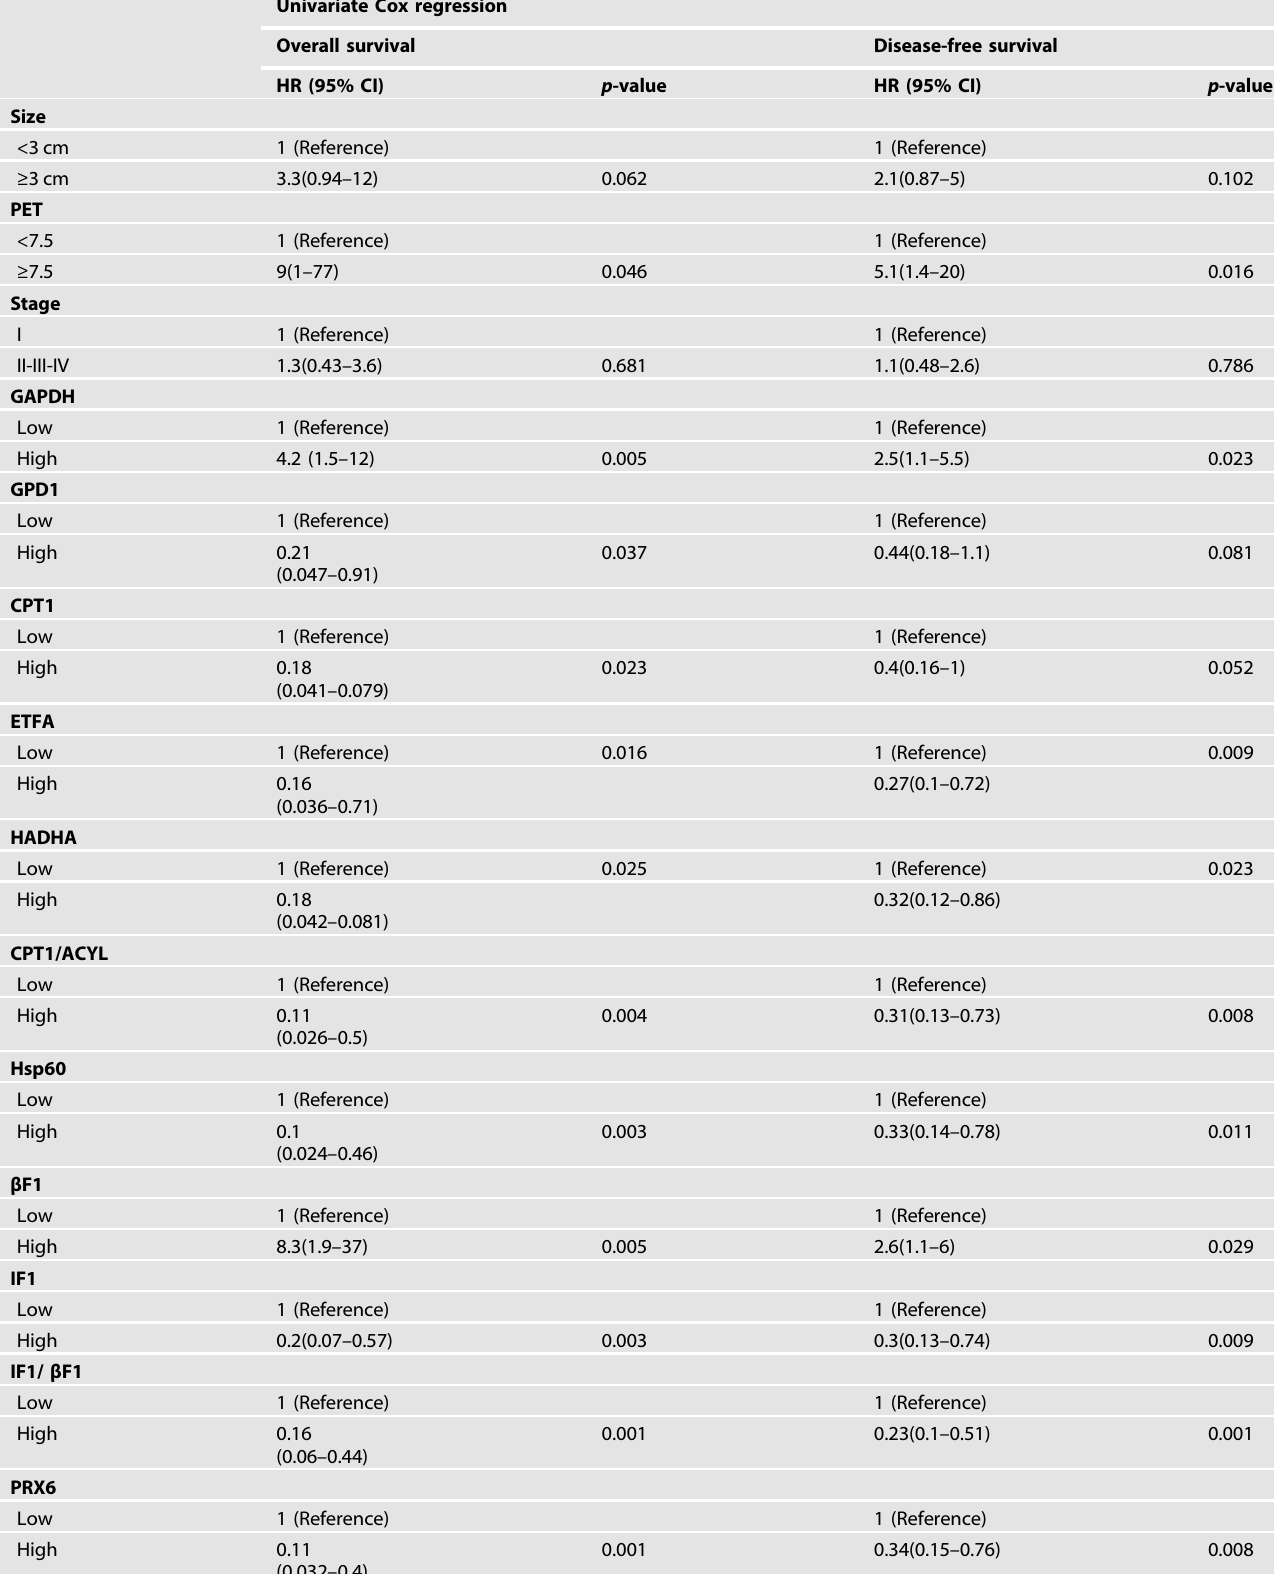
Table 1. Univariate and Multivariate Cox regression analysis of overall survival and disease-free survival in LUAD